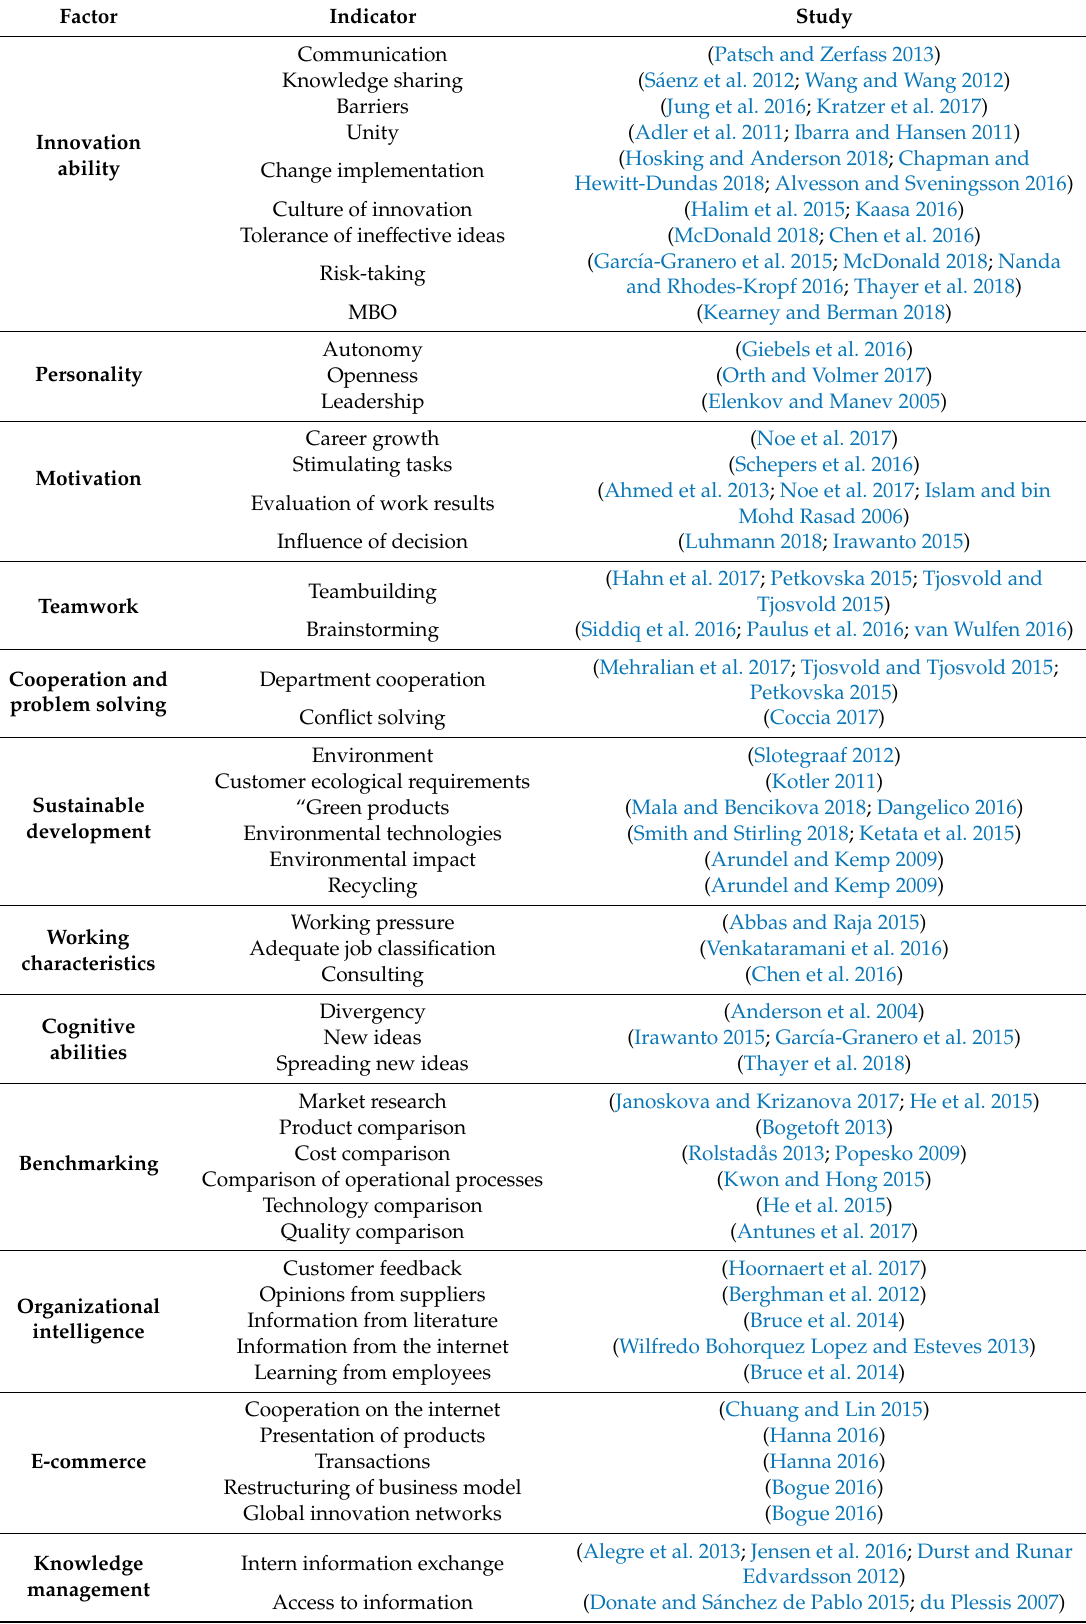
Table 1. Identified innovation